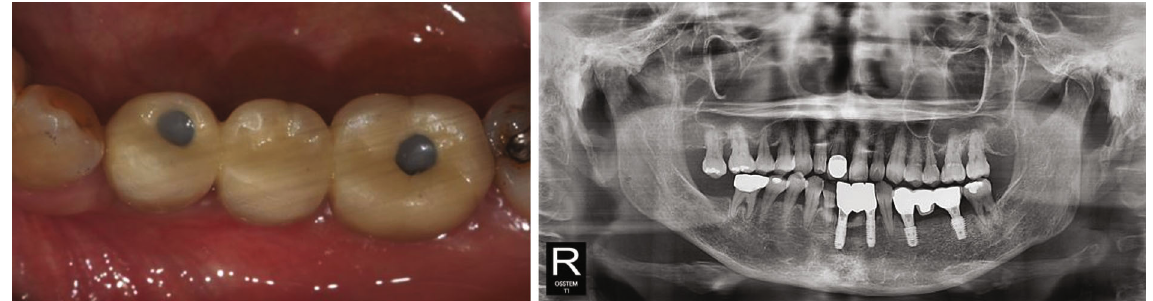
Figure 8: Finalprosthesesweredelivered(Case2).Theprostheses were maintainedwellwithoutany speci fi ccomplications